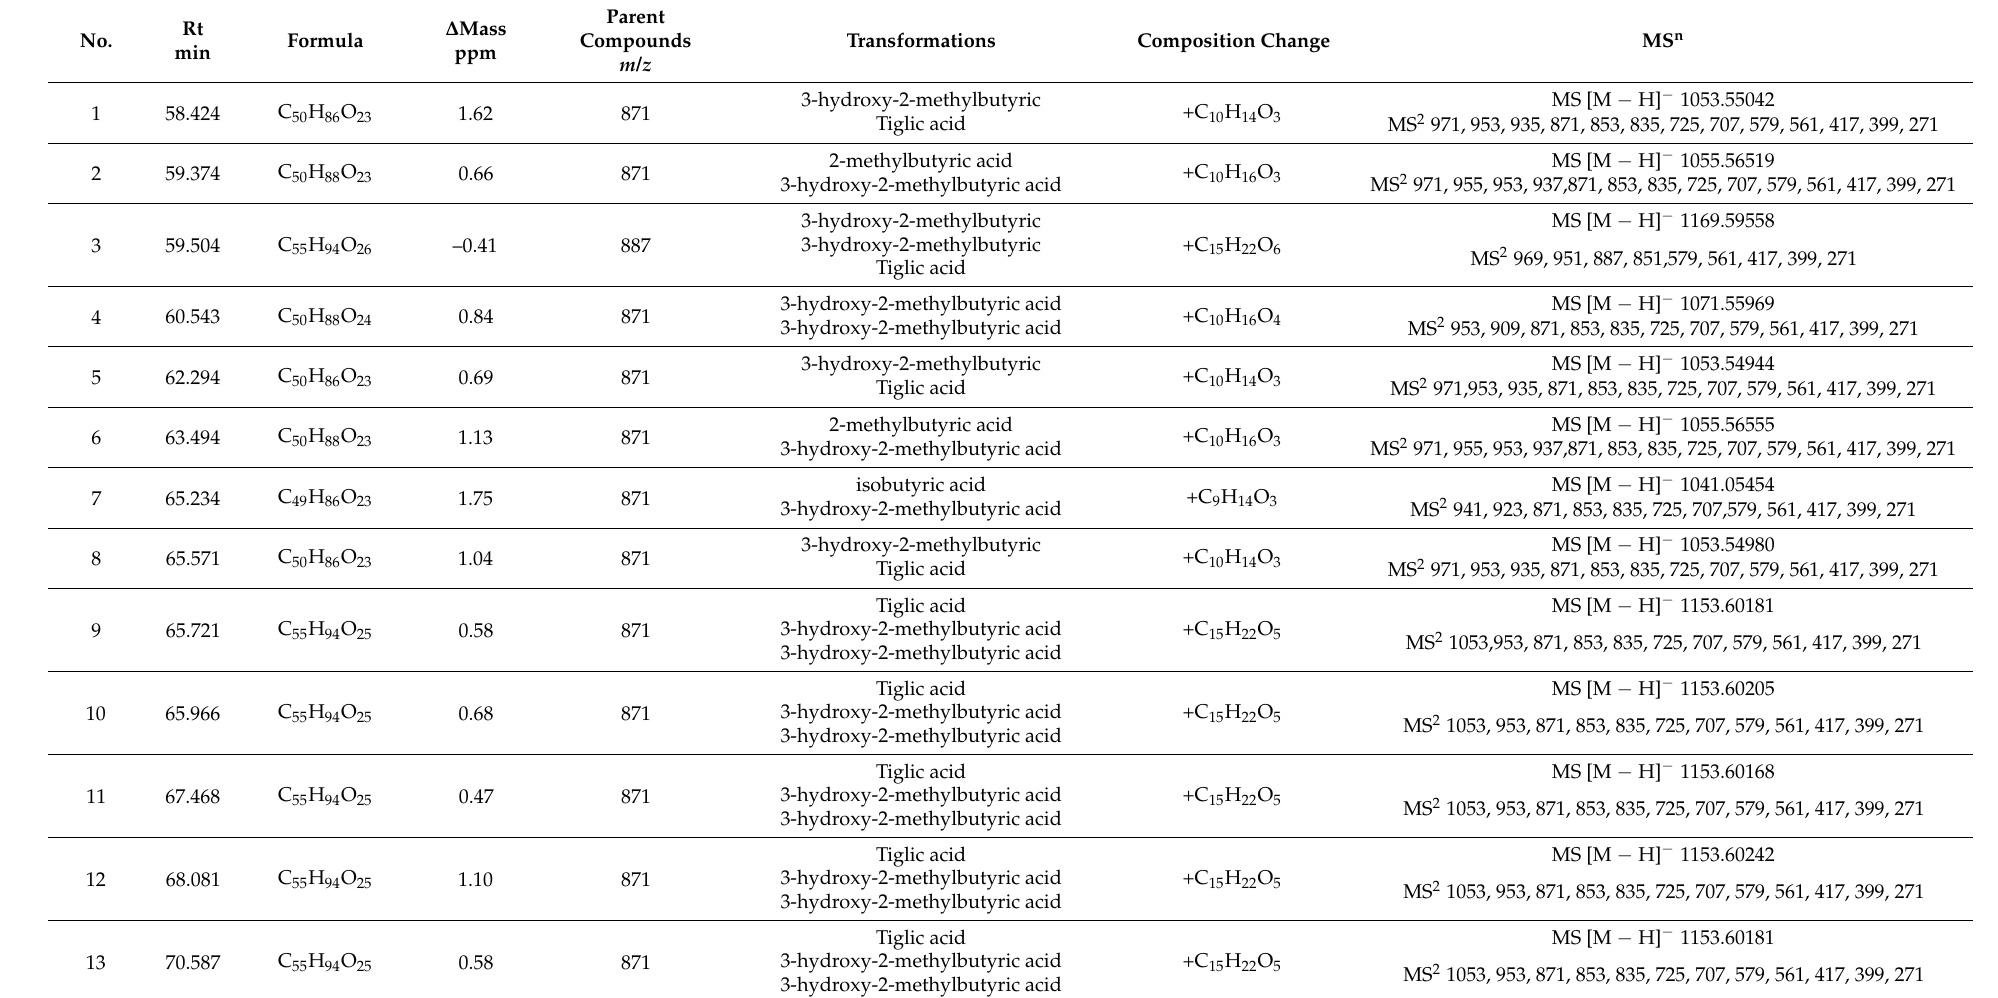
Table 4. Summary of the mass spectral data of characterized glycosidic acids in ESI negative ion